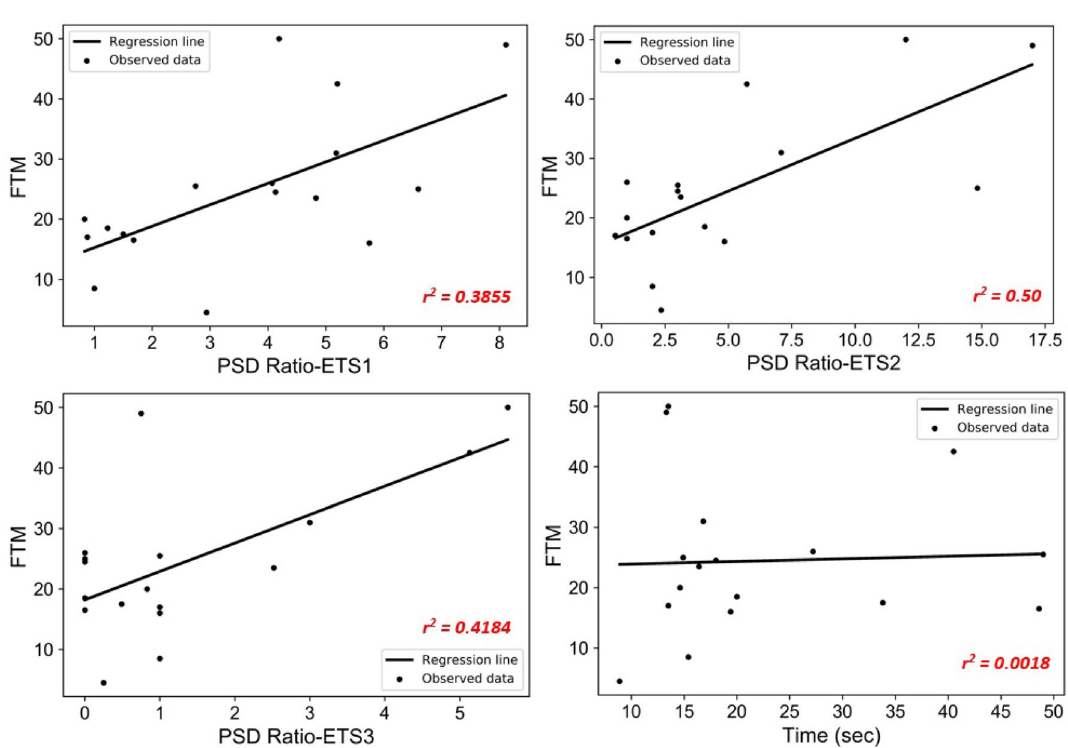
Figure 2. Regression analysis of the PSD ratio versus FTM score at three sensing